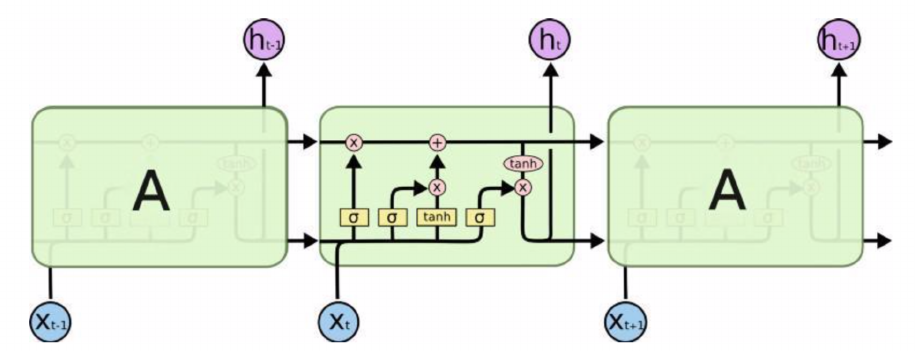
Figure 5. Simplified view of the neural network used in this work; RNN layers are the core of this network that is built to have up to N jets as input and only one output node according to the binary classification aim.